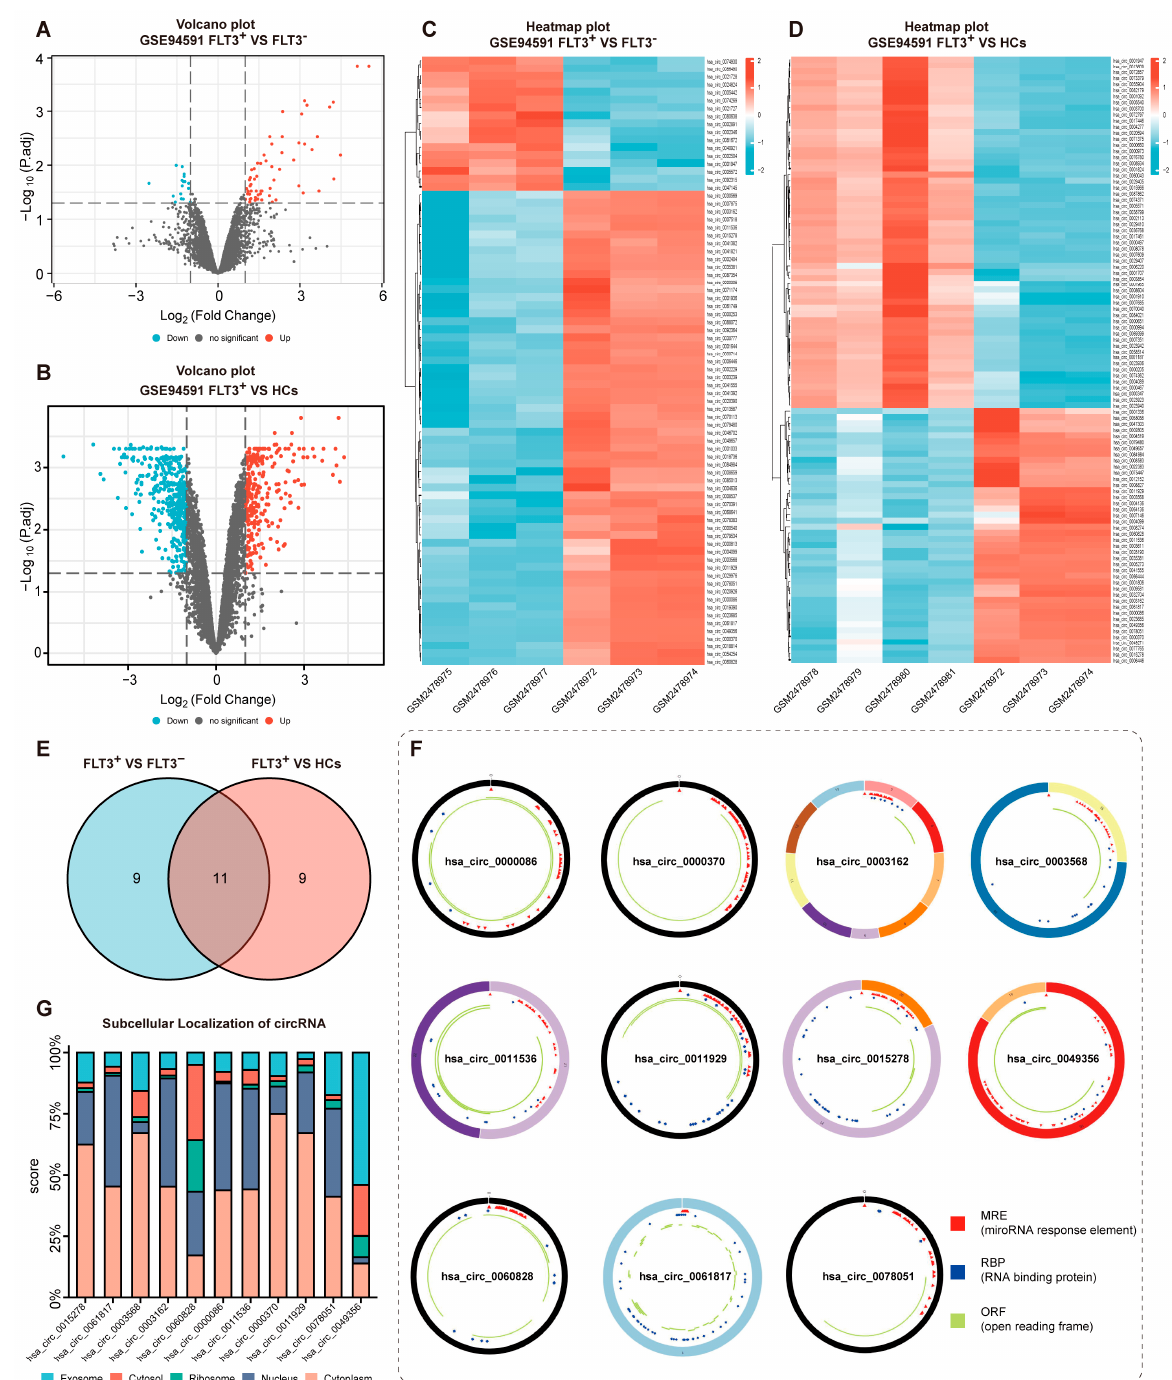
Figure 1. Identification of DECircs in AML. ( A ) Volcano plot of DECircs-1 from GSE94591 (FLT3 + VS FLT3 − ). ( B ) Volcano plot of DECircs-2 from GSE94591 (FLT3 + VS HCs). The red and blue dots represent up-regulated and down-regulated circRNAs, respectively. The vertical lines indicate two- fold upregulation and downregulation. The horizontal line represents adj. p = 0.05. ( C ) Heatmap of DECircs-1 from GSE94591 (FLT3 + VS FLT3 − ). ( D ) Heatmap of DECircs-2 from GSE94591 (FLT3 + VS HCs). Red and blue indicate high and low expression, respectively, and the color scales represent expression values. The columns represent samples, and the rows represent circRNAs. ( E ) Venn diagram of the intersection of the top 20 DECircs-1 and DECircs-2. ( F ) CSCD presents structural